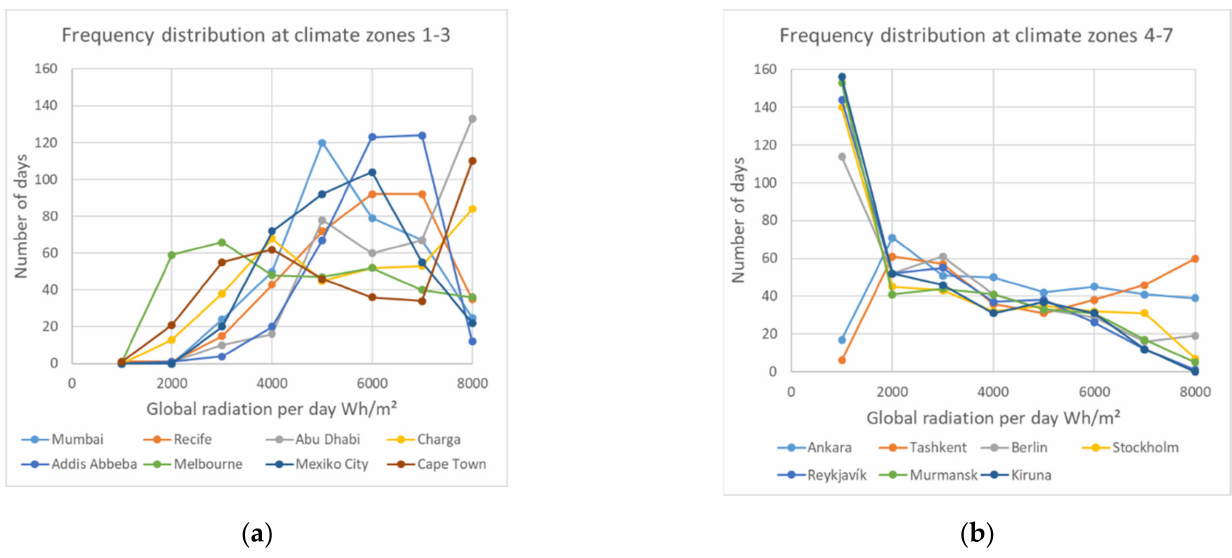
Figure 4. Frequency distribution of daily global radiation for selected cities. ( a ): Hot and warm climate zones 1–3. ( b ): Cool and cold climate zones